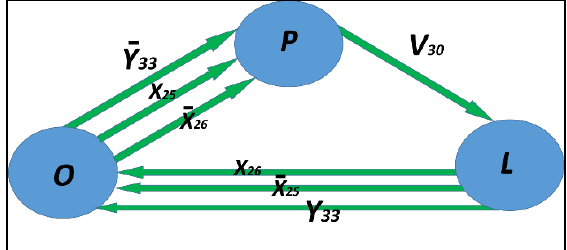
Figure 8. Automatic graph of the valve